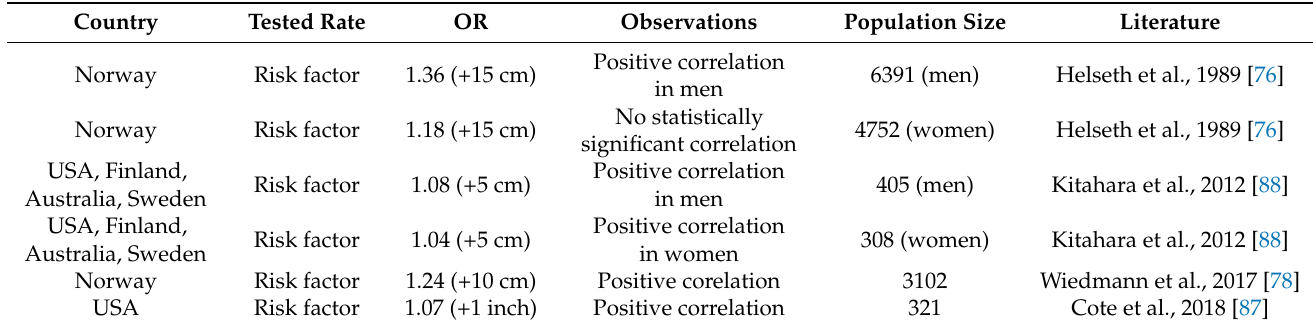
Table 4. Height as a GBM risk factor: review of the